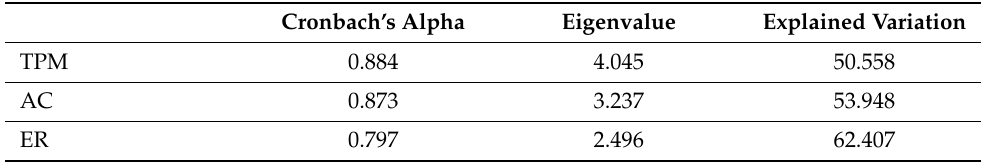
Table 1. Cronbach’s Alpha and summary of results of factor